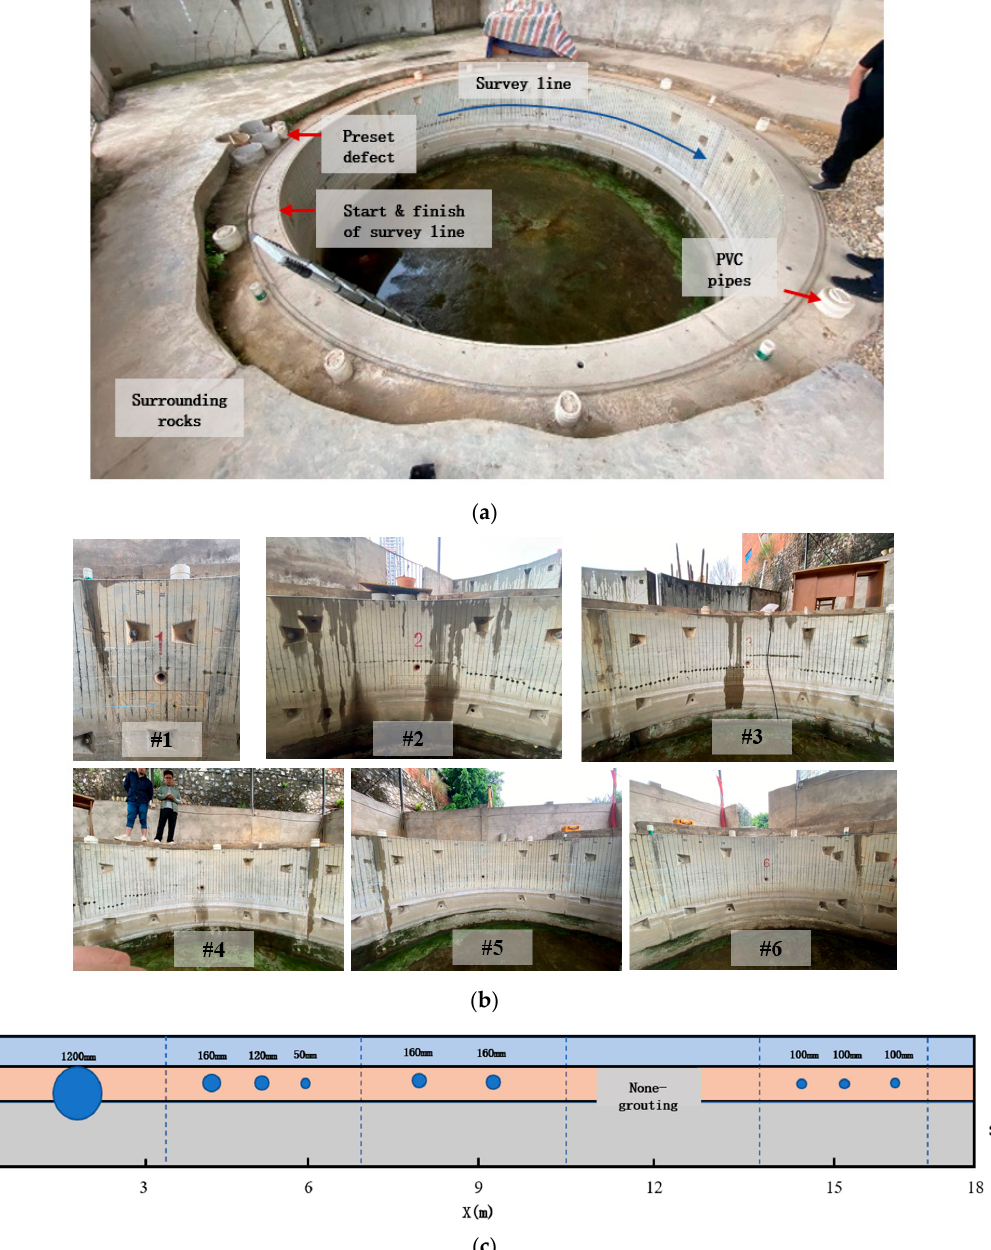
Figure 3. The full-size test model. ( a ) Full-size experimental segment model; ( b ) Six segments in the model; ( c ) A flattened illustration of the segment model with grouting defects.